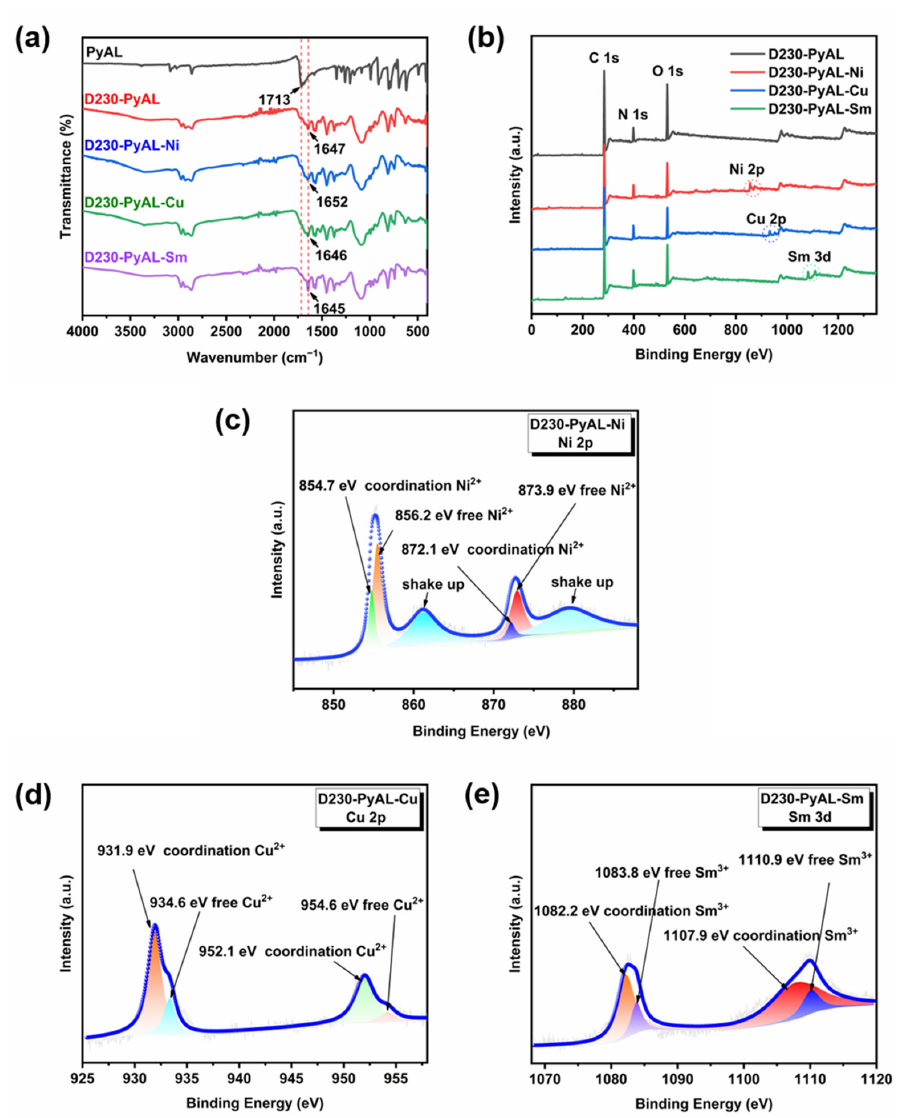
Figure 2. ( a ) FTIR and ( b – e ) XPS spectra of polymers and coordination polymers.